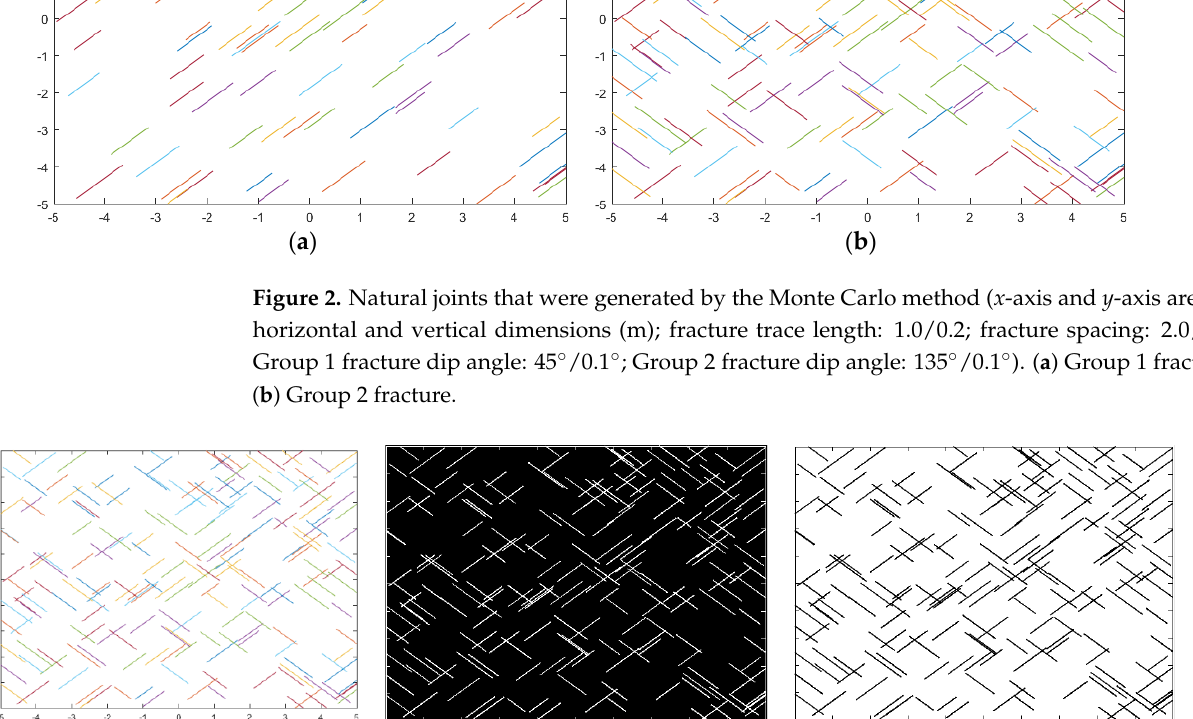
Figure 3. The binarization processing of the natural joint distribution (x-axis and y-axis are the horizontal and vertical dimensions (m)).